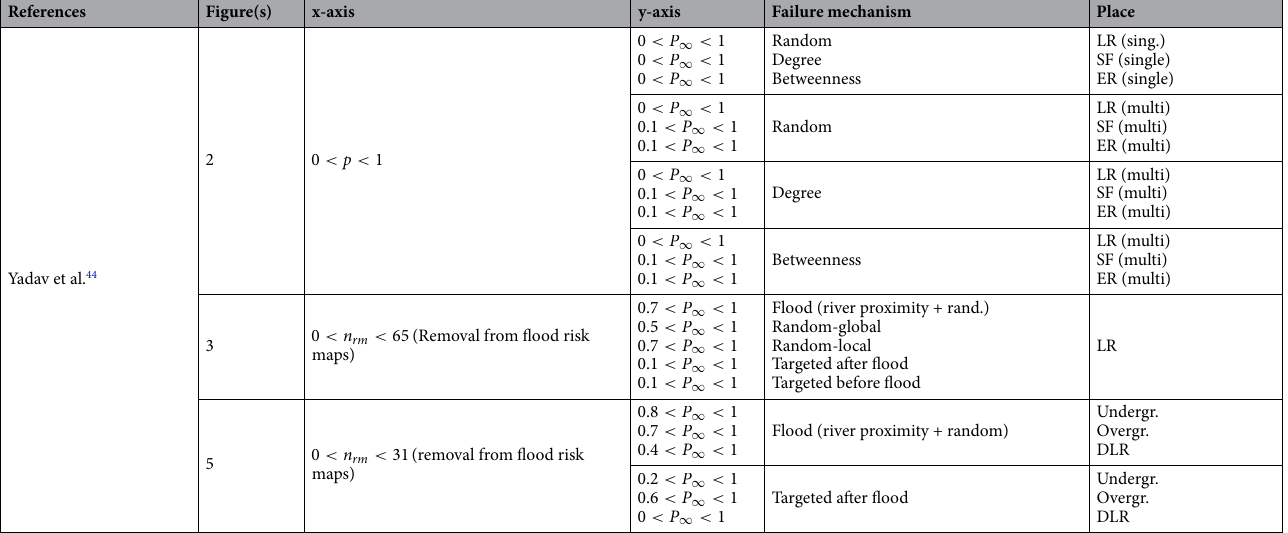
Table 1. This is a summary of the reviewed articles which discuss the application of percolation processes to road networks, as proxies of flooding events. In the table header, Figure(s) indicates the Figure’s number in the reference paper which is related to the percolation process, while x-axis and y-axis represent the axes of the percolation process’s graphic. The x-axis covers a number of roles, as fraction of removed nodes, p , time, t (days), surface runoff, R ( mm day ), and number of removed nodes, n rm , while the y-axis mostly represents the giant connected component, P ∞ . In a few cases the percolation-based process (y-axis) is represented by the global efficiency of Latora and Marchiori 45 , or by the Fan et al. 38 fraction of flooded grid cells, c ( t ), by the Dong et al. 28 robust component, RC , or by the traffic delay in Ganin et al. 42 . About the last two columns, i.e the failure mechanism and place , please refer to the corresponding reference papers for further details. Note to the reader ( a ): both in Figure Sup. 3 and in Sup. 4, in Wang et al. 43 , each range of 1 − p values refers to the Chinese province or American state on the same table row (Guangxi, Henan, Hunan, etc., or Florida, Illinois, Iowa, etc.), while each range of P ∞ values refers to the failure mechanism on the same table row. However, to relate the unique range of P ∞ , here shown in this table, to all the Chinese provinces mentioned in Sup. 3 (if reading Figure Sup. 3), or to all the American states mentioned in Sup. 4 (if reading Figure Sup. 4), the minimum value of P ∞ was selected among those ones associated to the provinces or states in 43 and shown here as the overall lower endpoint of P ∞ . Therefore, for each failure mechanism, the corresponding range of P ∞ contains the minimum value of P ∞ among all the values of the Chinese provinces or American